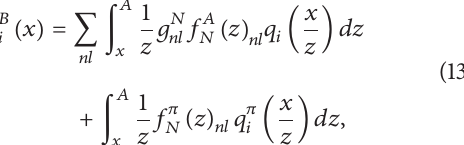
Figure 1: Drell-Yan process, a quark with fraction of momentum 𝑥 1 in the hadron 𝐴 and an antiquark with fraction of momentum 𝑥 2 in the hadron 𝐵 collide and annihilate to create a photon. This virtual photon with mass 𝑚 = √𝑥 1 𝑥 2 𝑠 decays into a lepton pair